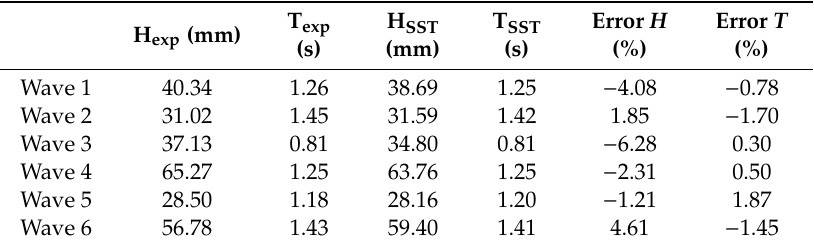
Table 7. Comparison of the wave height and period of the resultant wave between the experimental and SST model, and the error between them.